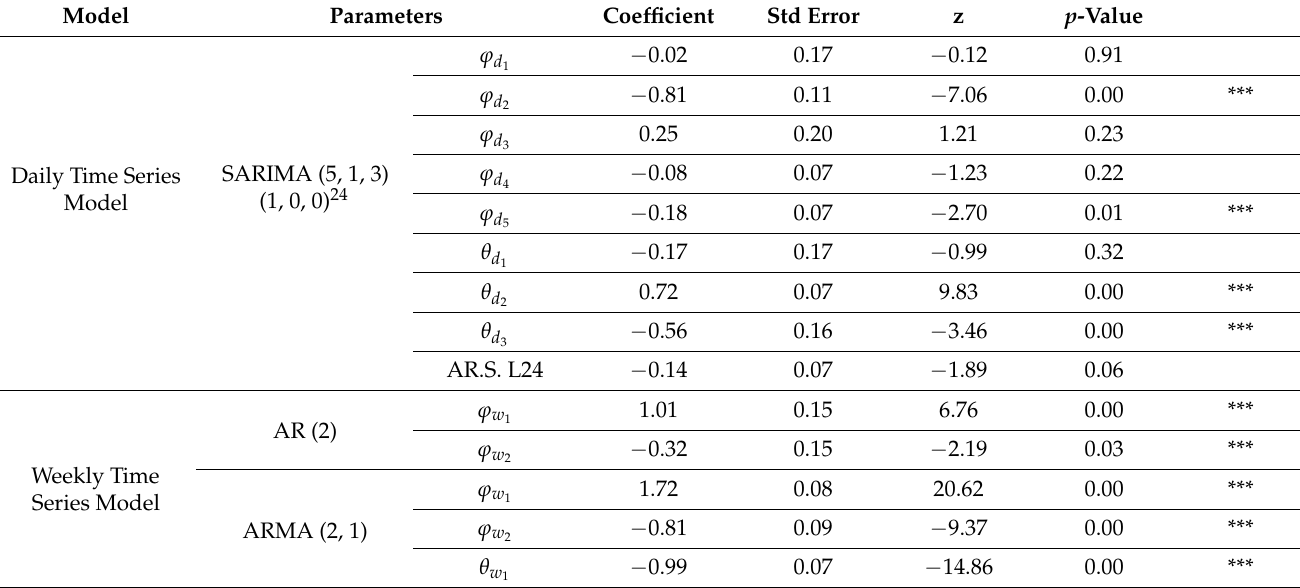
Table 2. Parameters of daily and weekly time series model for the Box–Jenkins.